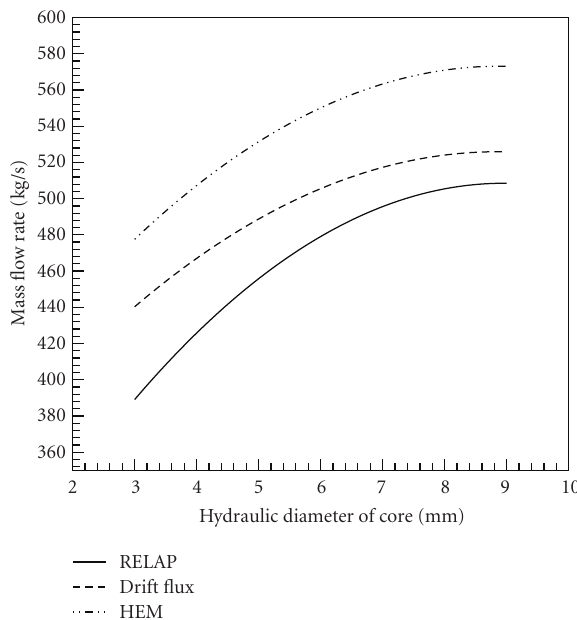
Figure 6: Variation of mass flow rate with hydraulic diameter of the core.